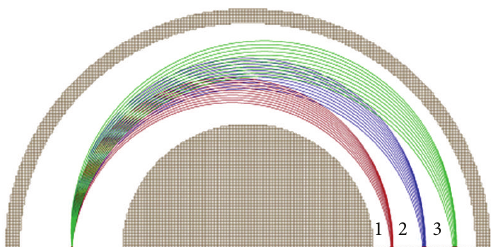
Figure 7: SIMION simulations of the pass of different energy electrons through the hemispherical analyzer. The beam of number 1 shows the electron energy of 100eV, number 2 shows the electron energy of 200eV, and number 3 shows the electron energy of 280 eV.